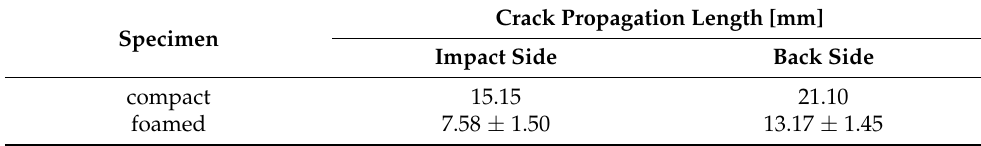
Table 5. Transverse crack propagation length for compact and foamed specimen.